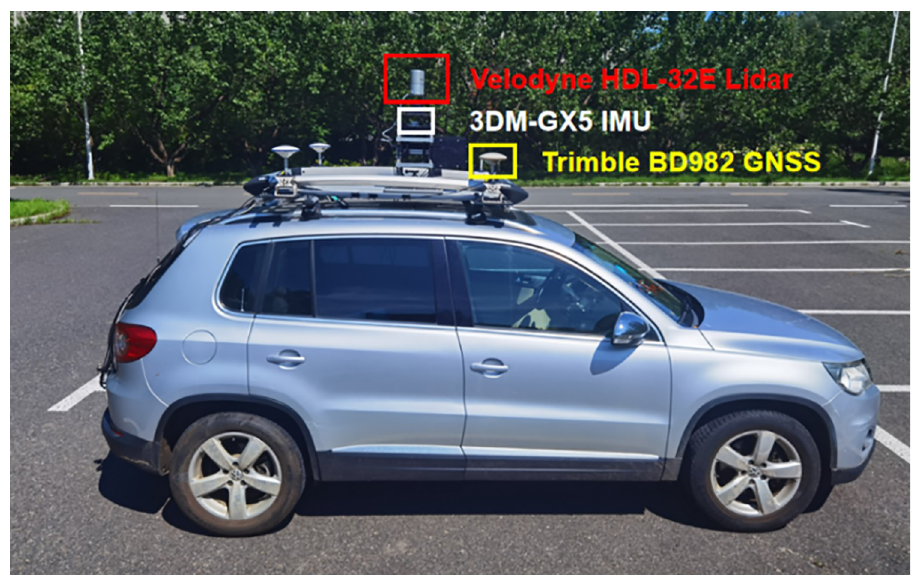
Fig 7. Recording platform (Volkswagen Tiguan) with sensors.